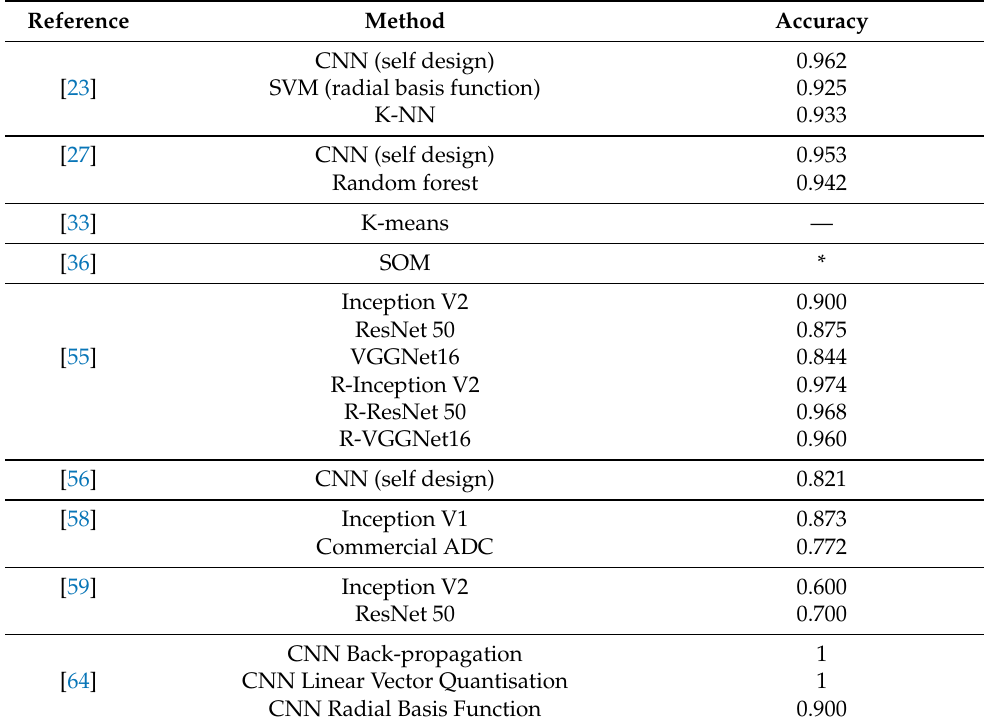
Table 2. Methods and their